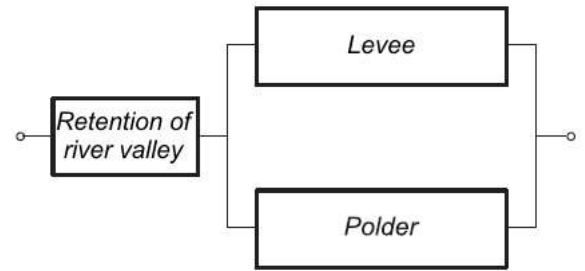
Figure 2. Reliability structure (reliability block diagram) of the Sola River catchment’s hydrological system up to the Zywiec post. This structure reflects system function and element reliability and does not represent the actual location of system elements.